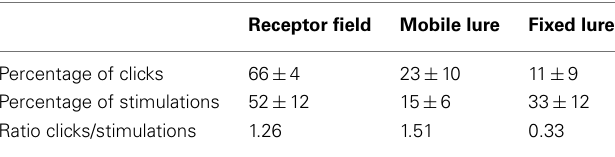
Table 1 | Distribution of the clicks and of the tactile stimulations – experiment